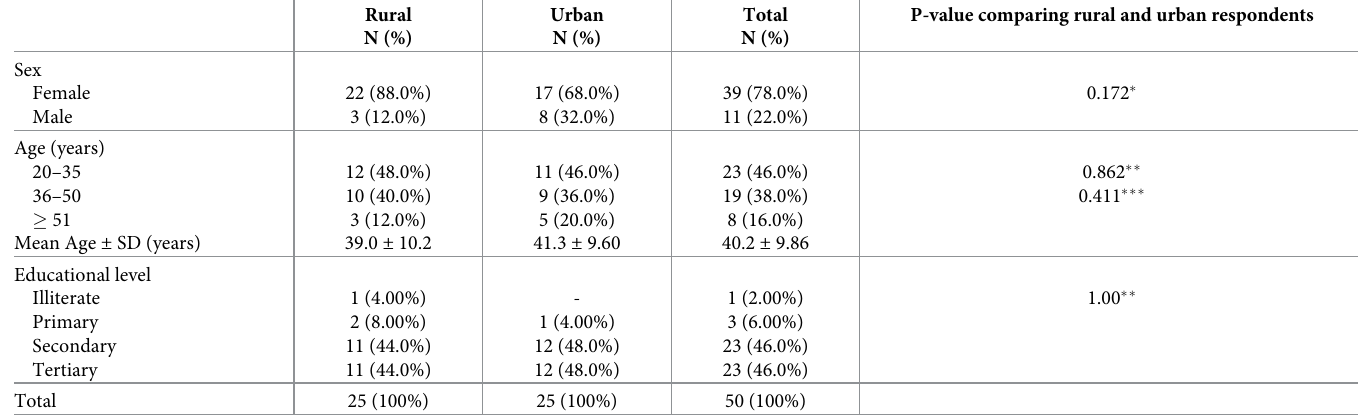
Table 1. Demographic characteristics of survey respondents.